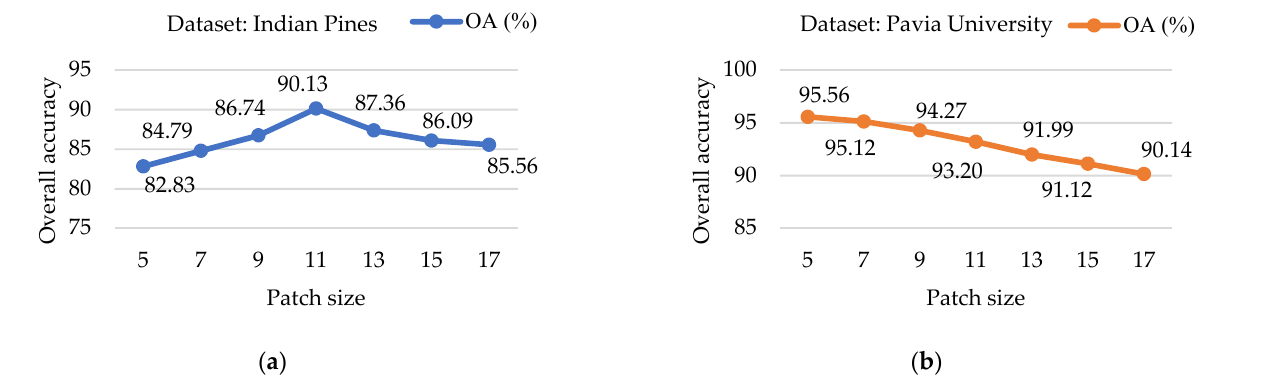
Figure 10. Accuracy of different patch sizes for two datasets. ( a ) Results for different patch sizes for the Indian Pines dataset. ( b ) Results for different patch sizes for the Pavia University dataset. Table 2. Training time for seven patch sizes for the two datasets. Dataset: Indian Pines